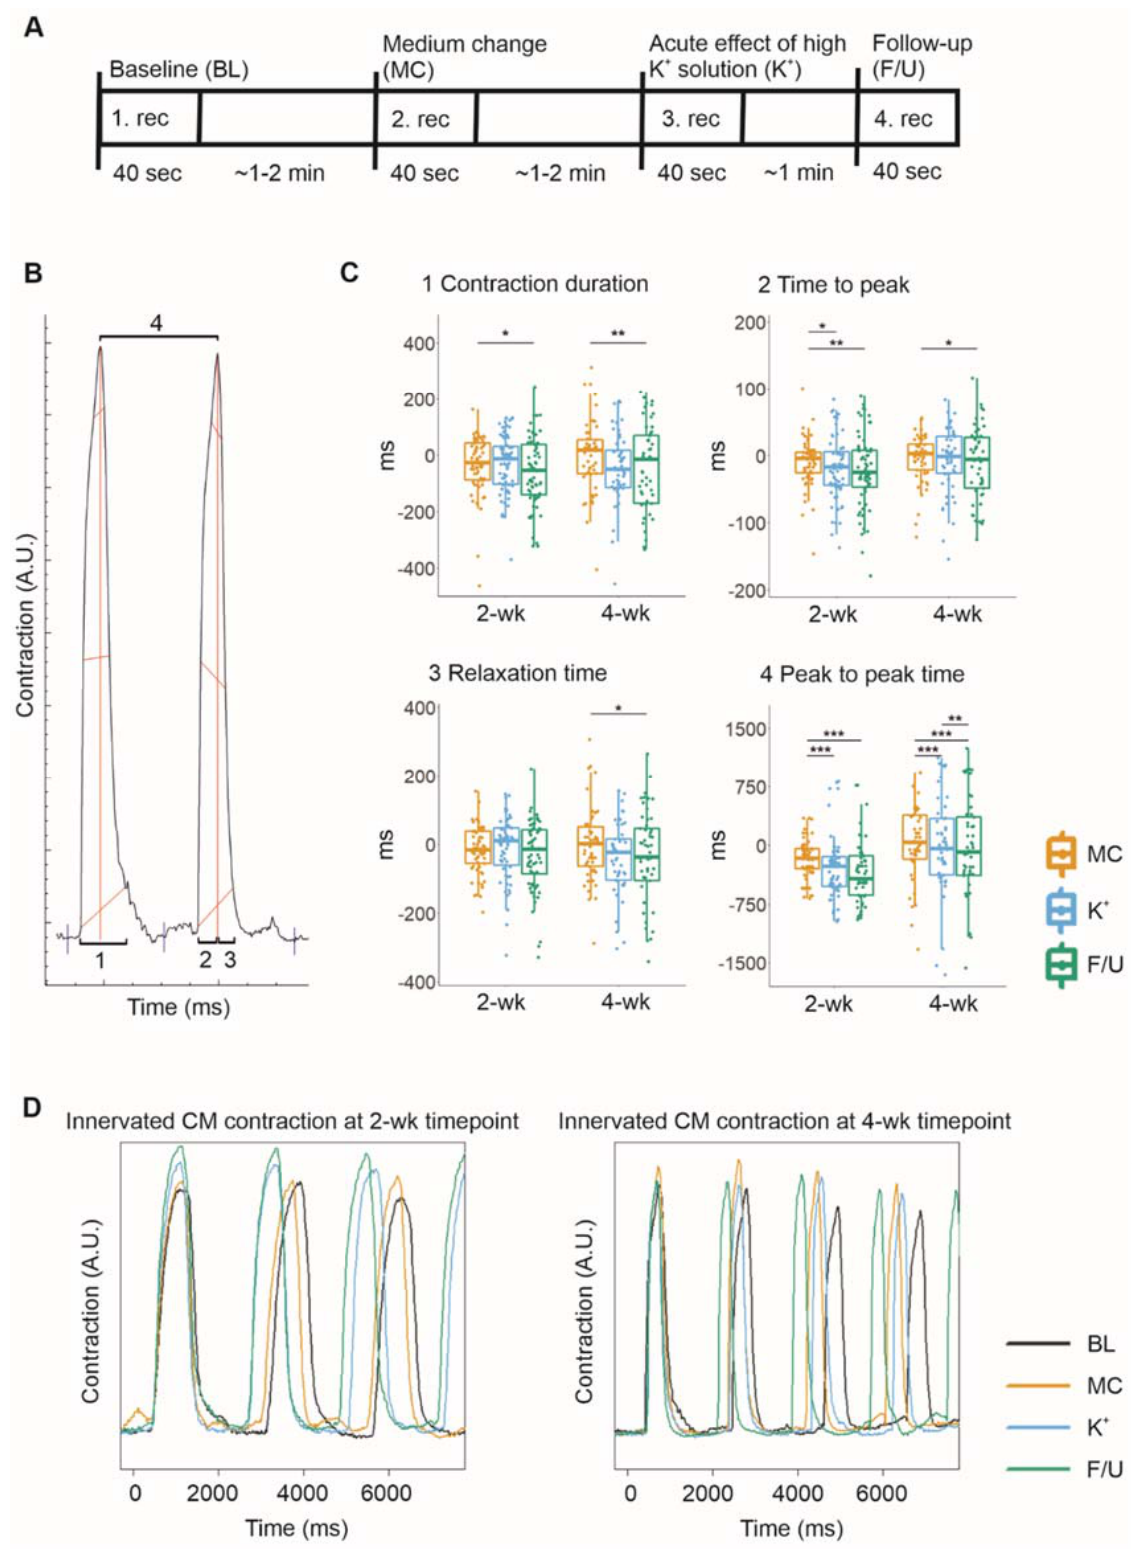
Figure 4. The evaluation of the functional connections between the cocultured hiPSC ‐ neurons and hiPSC ‐ CMs was performed by video microscopy recording of CMs beating during high K + exposure of the neurons. The data are presented as boxplots overlaid by individual datapoints. ( A ) Experimental timeline for the recording of CMs beating during neuronal exposure to a high ‐ K + solution. ( B ) MUSCLEMOTION was used to analyze the videos for the contraction duration (1), time to peak (2), relaxation time (3), and peak ‐ to ‐ peak time (4). ( C ) The response to medium change (MC) was considered the baseline response, to which the immediate (K+) and follow ‐ up (F/U) responses to neuronal high K + exposure were compared. After K + exposure, the contraction duration was observed to decrease, mostly due to a decrease in the time to peak. Furthermore, the peak ‐ to ‐ peak time of cardiomyocyte beating was observed to decrease, indicating an increased beating rate. ( D ) Examples of contraction curves acquired from MUSCLEMOTION analysis of the recorded videos. * p < 0.05, ** p < 0.01, *** p < 0.001.